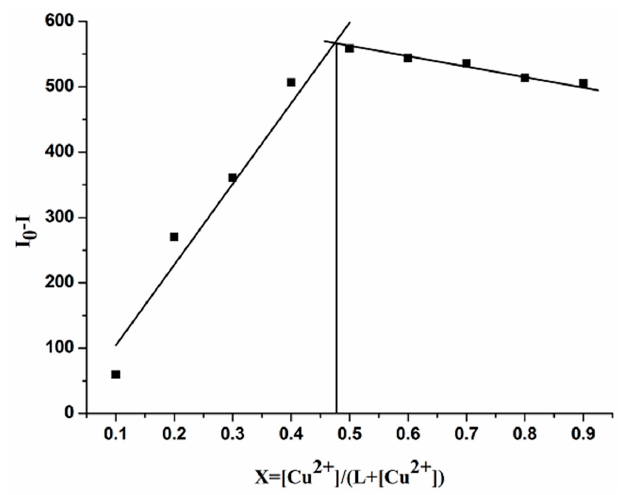
Figure 3. Job plot to determine the stoichiometry of the [ L -Cu 2+ ] complex in solution.